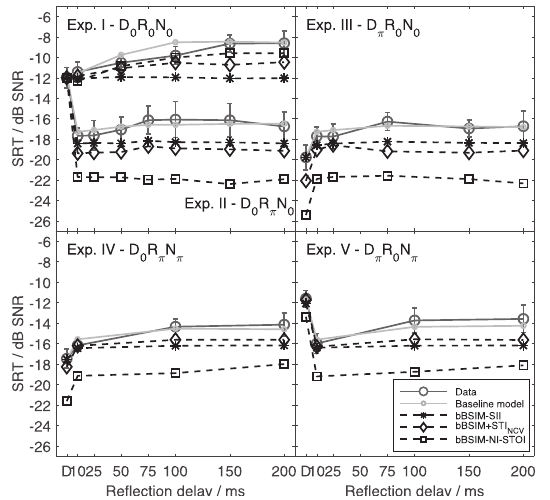
Figure 3. Measured (big, dark gray circles) and predicted SRTs for experiments I to V with the baseline model (small, light gray circles), bBSIM-SII (black stars connected with black dashed line), bBSIM-STI NCV (black diamonds connected with dashed lines), and bBSIM-NI-STOI (black squares connected with dashed lines). This fi gure shows the in fl uence of a single re fl ection of the target speech at different delays. Note that the fi rst condition is always direct sound only.